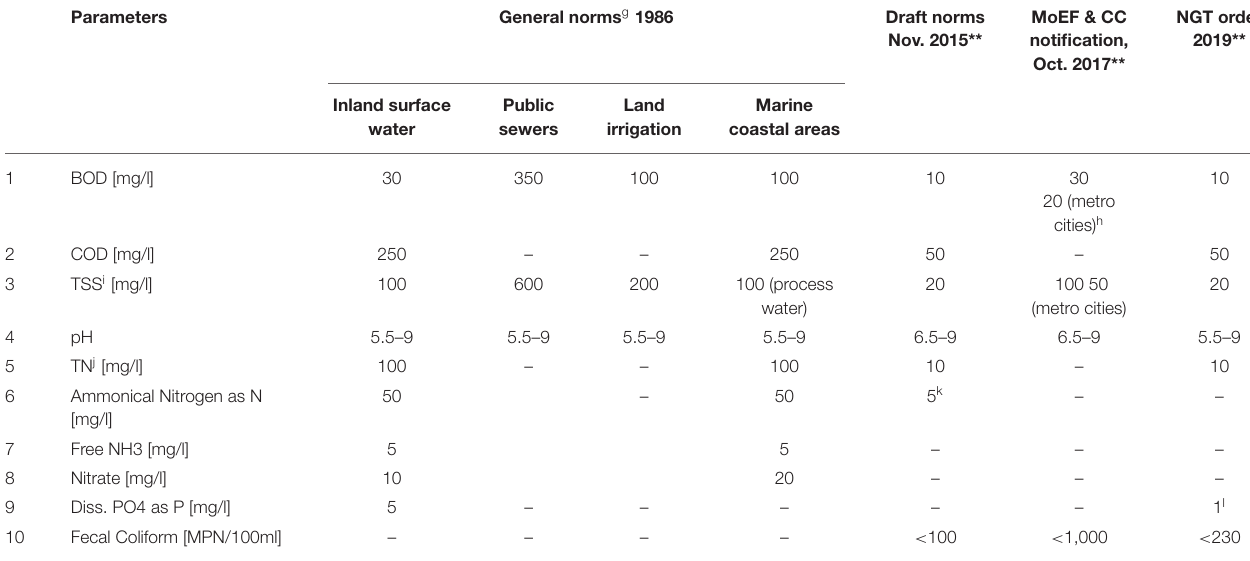
TABLE 5 | Overview Indian STP discharge standards over time (MoEFCC, 1986b, 2015, 2017b; National Green Tribunal order,